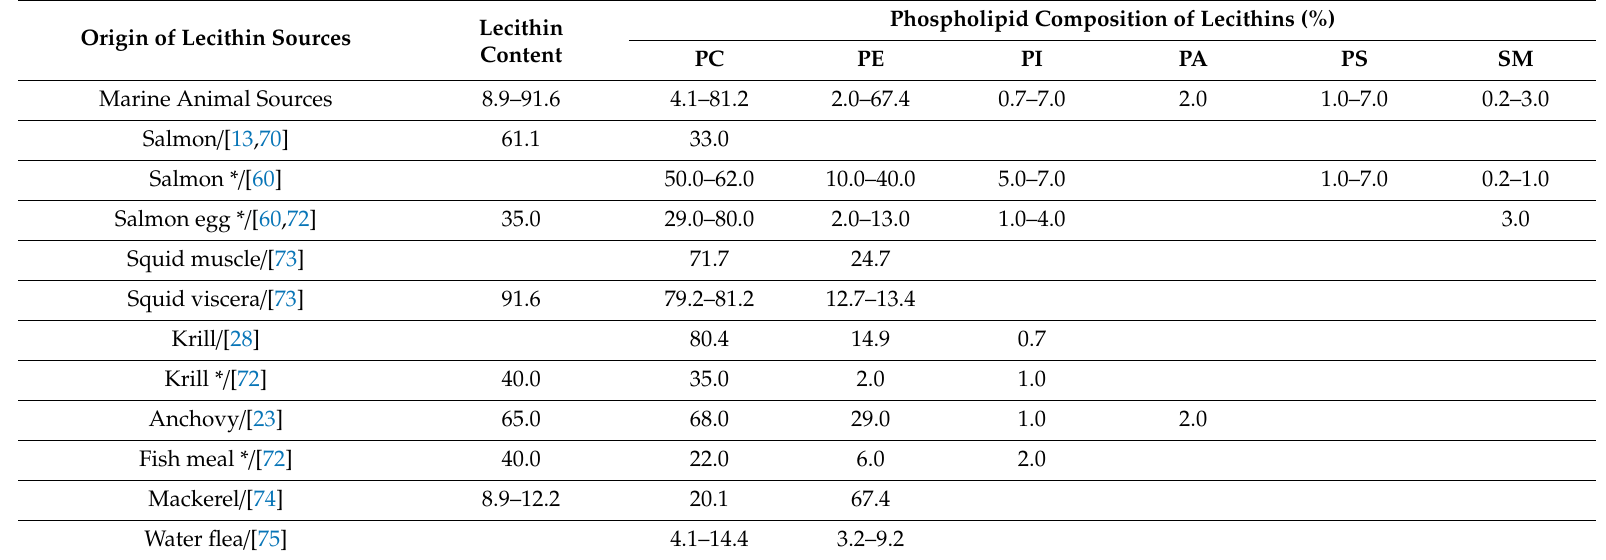
Table 3. Phospholipid composition of natural lecithins from marine animal